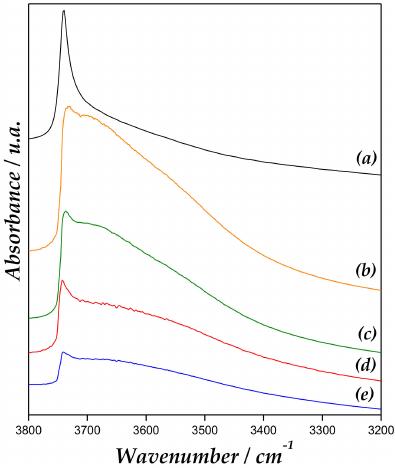
Figure 7. FT-IR region of OH after pyridine adsorption and desorption of (a) MCM-41, (b) Zn/ MCM-41(1), (c) Zn/MCM-41(2.5), (d) Zn/MCM-41(10), and (e) Zn/MCM-41(15) at 200 ◦